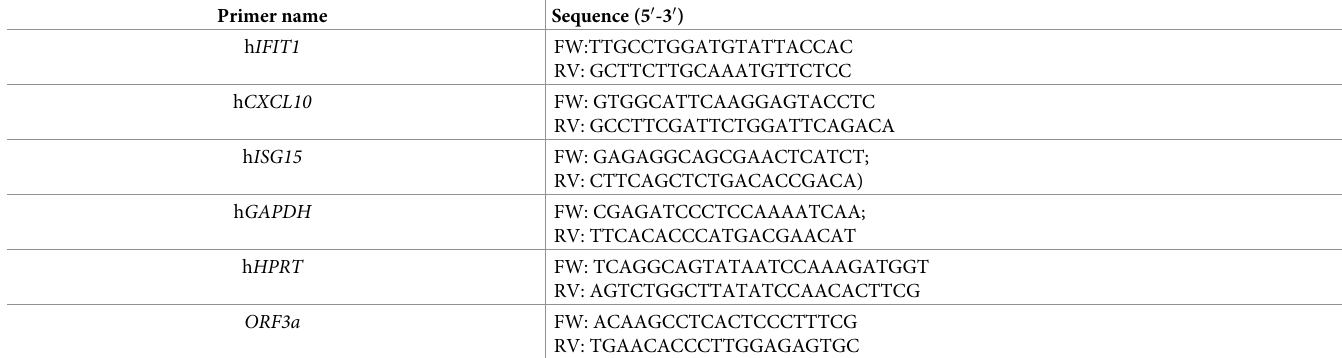
Table 1. Primers used in the present